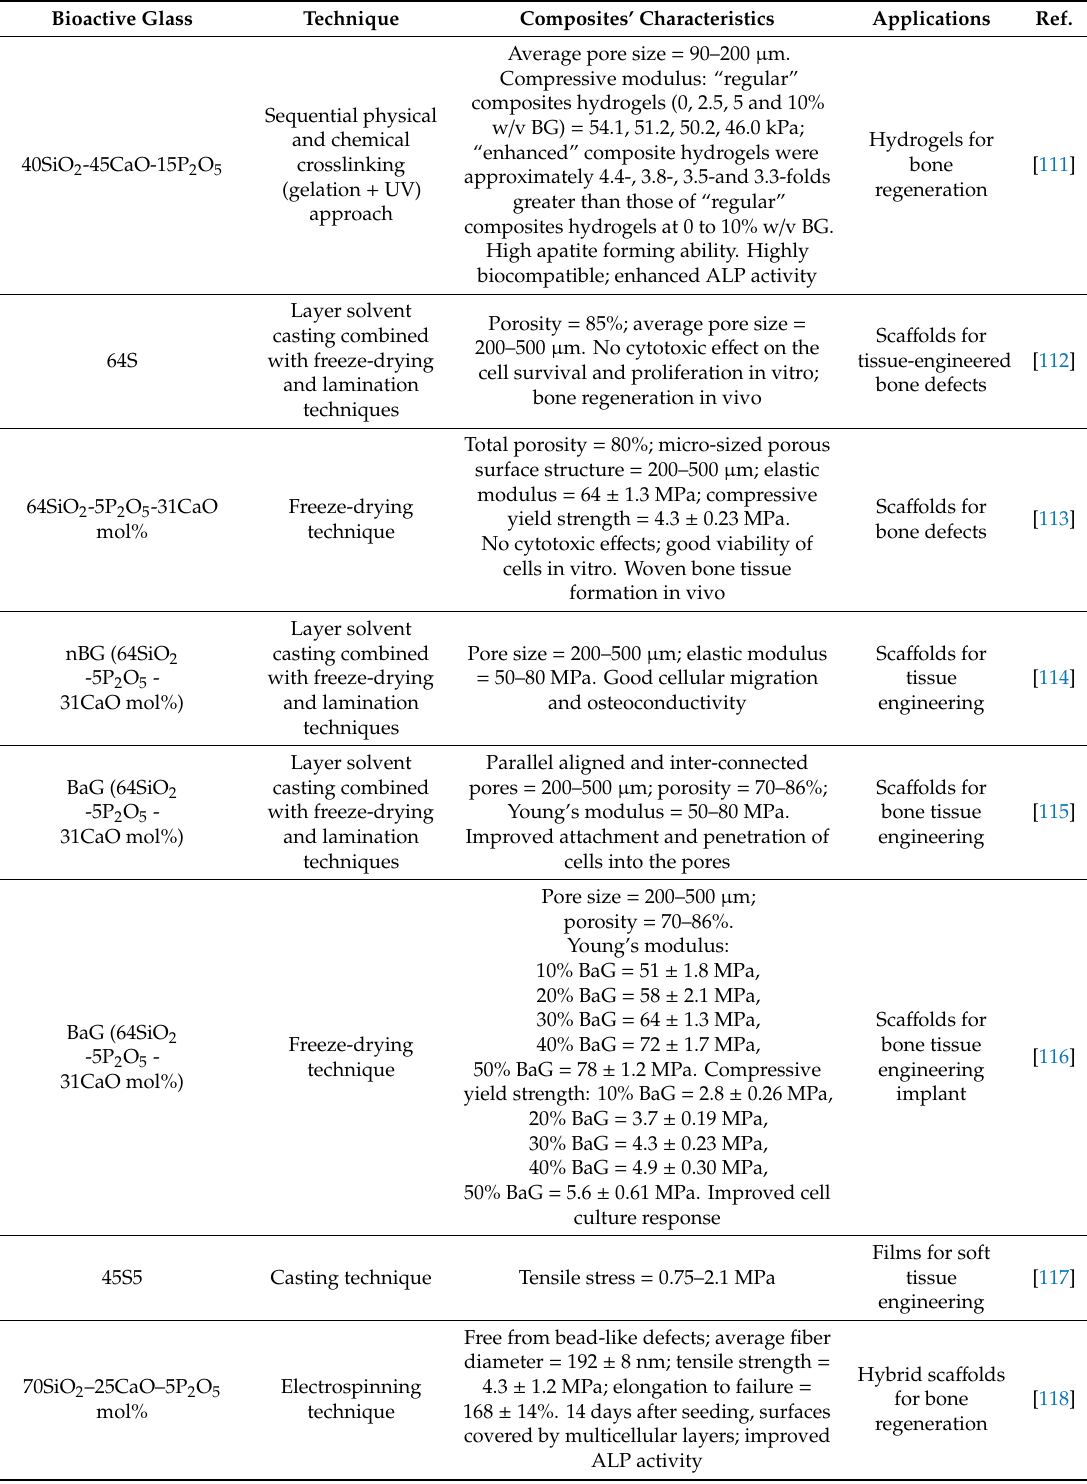
Table 2. Summary of gelatin / bioactive glass composites for various biomedical applications. Bioactive